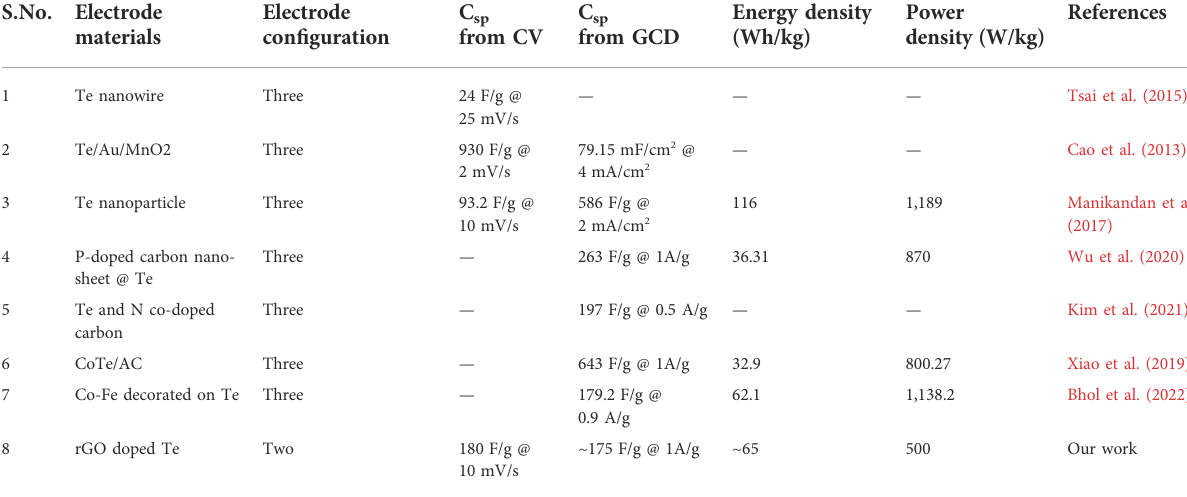
TABLE 4 Comparison of electrochemical performance parameter of the supercapacitor based on